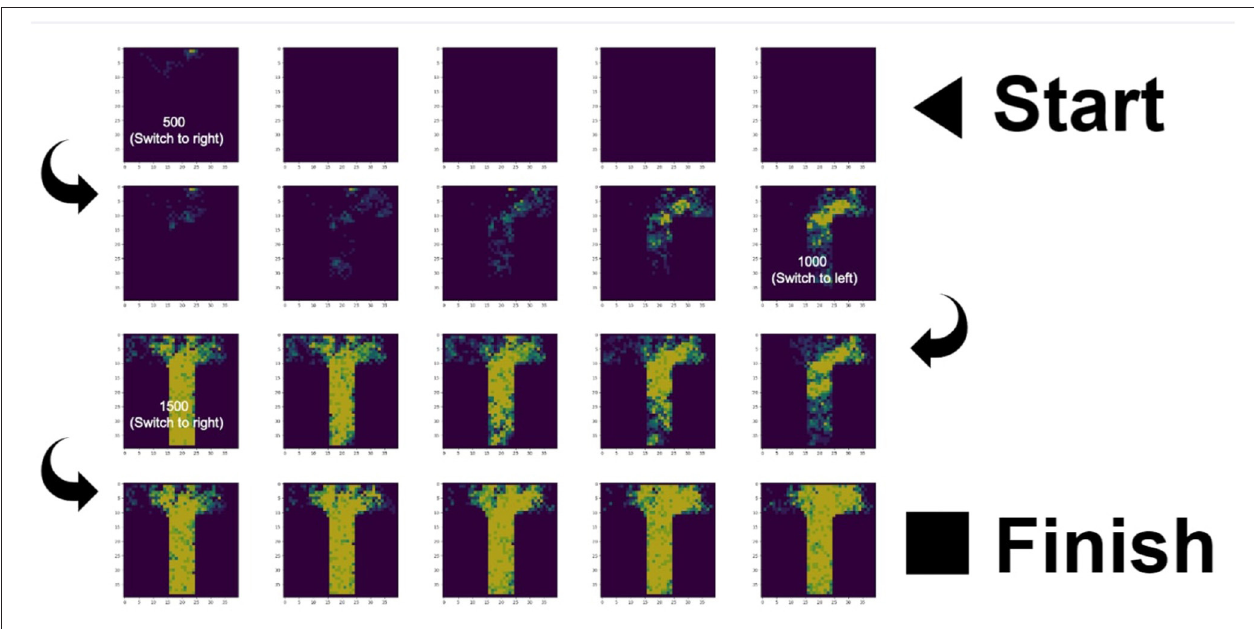
FIGURE 2 | Pheromone trails of the colony with 70 nestmates over 2,000 timesteps and three food location switches. The sequence of images starts on the top right and reads from right to left (1st row), from left to right (2nd row), from right to left (3rd row), and from left to right (4th row). We chose a representative simulation and did not tune the parameters to discover optimal decision making. See Supplementary Files 6, 7 for example simulation outputs and to see the switching behavior (pheromone density locking onto one arm, then gradually locking onto the other arm) that is observed in the case of strict priors but not flat priors.